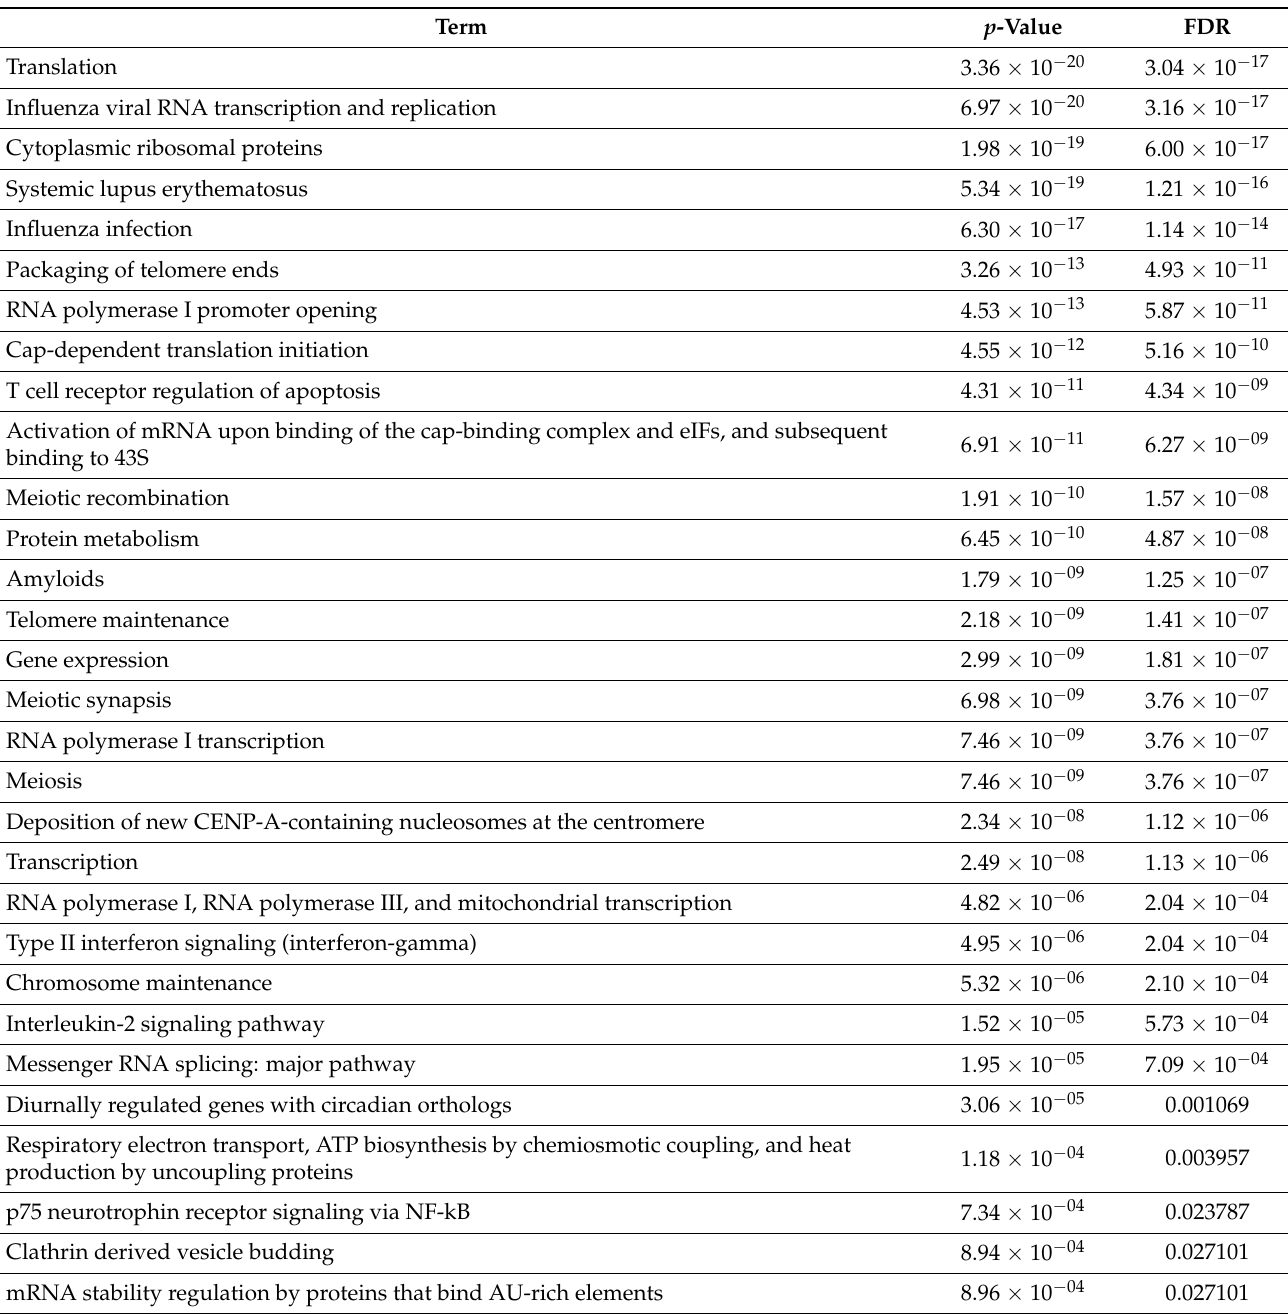
Table 1. Top significant 30 biological pathways affected by down-regulated genes in H3K27ac ChIP-Seq analysis of delayed versus immediately processed blood-derived CD4 + T-cells from atopic